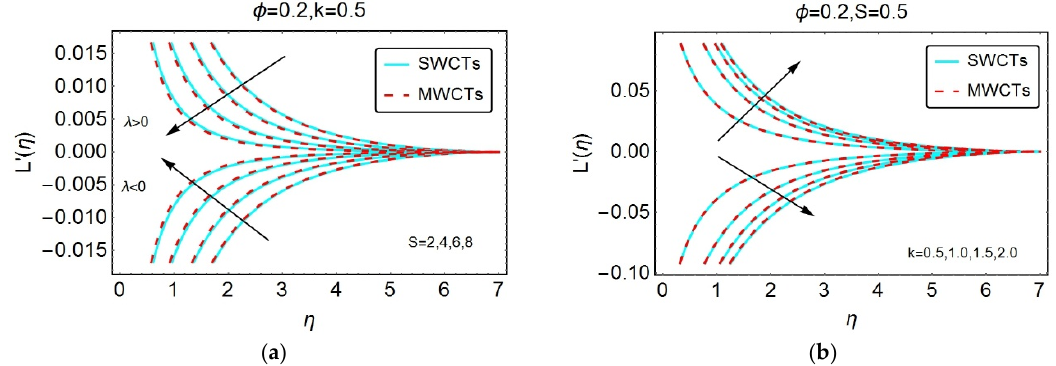
Figure 2. The velocity behavior L′(η) for ( a ) suction and ( b ) curvature parameters.